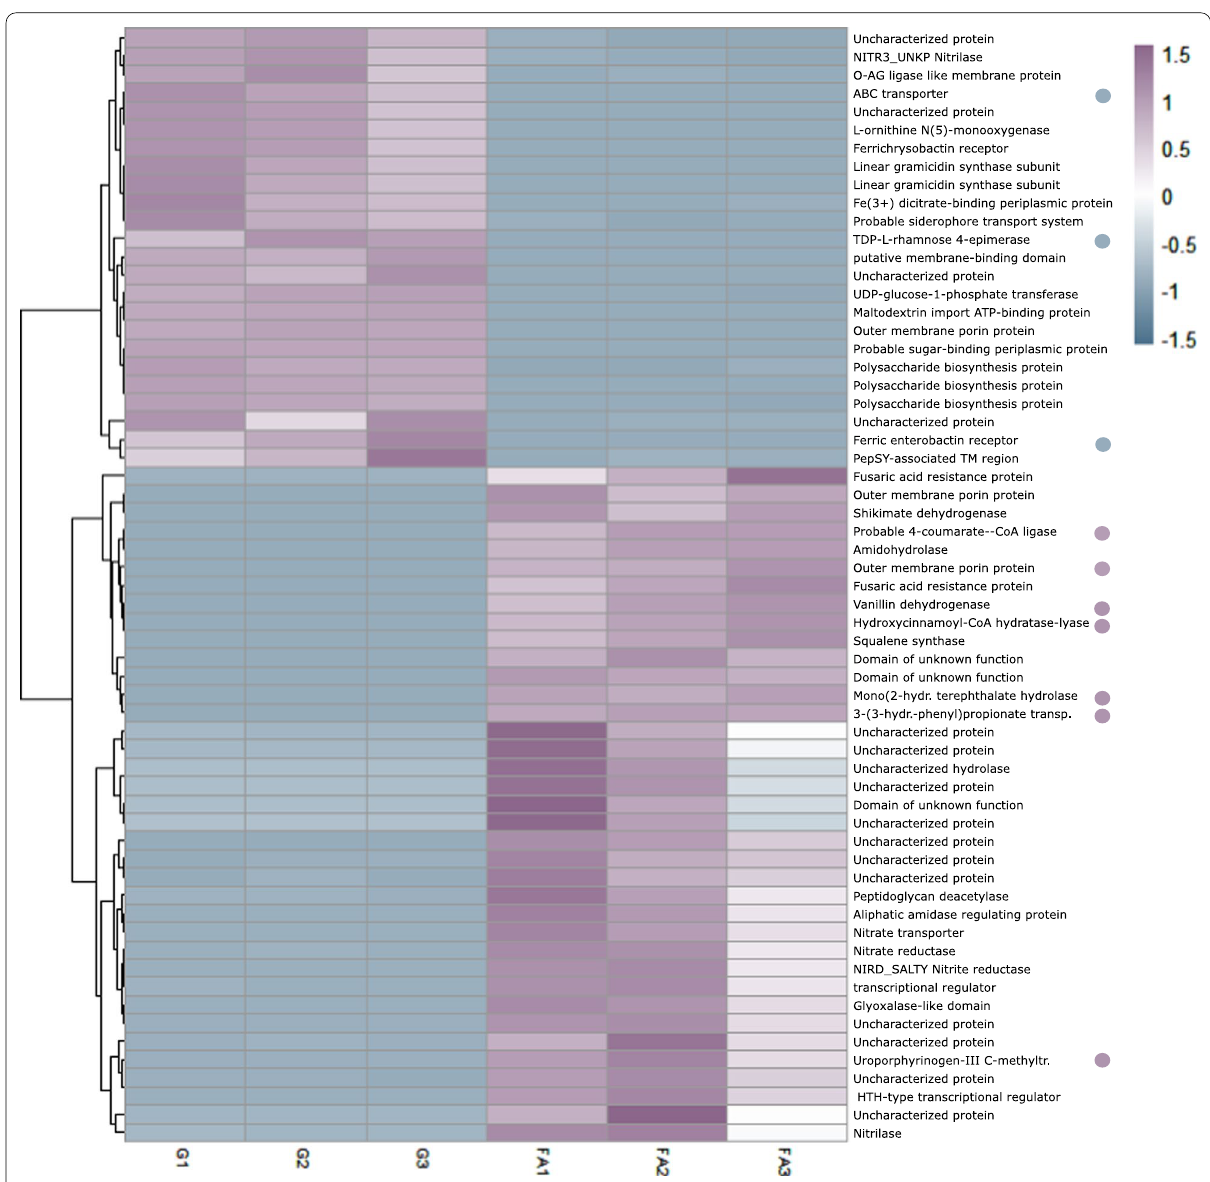
Fig. 2 Heatmap of expressed transcripts of the biological triplicates. Biological replicates cultivated with glucose as sole carbon source are marked with G1-3 (left columns) and biological replicates cultivated with ferulic acid as sole carbon source with FA1-3 (right columns). Values presented are fold change > 50. Upregulation is marked in violet (values 0 listed on the right, dots mark genes involved in FA